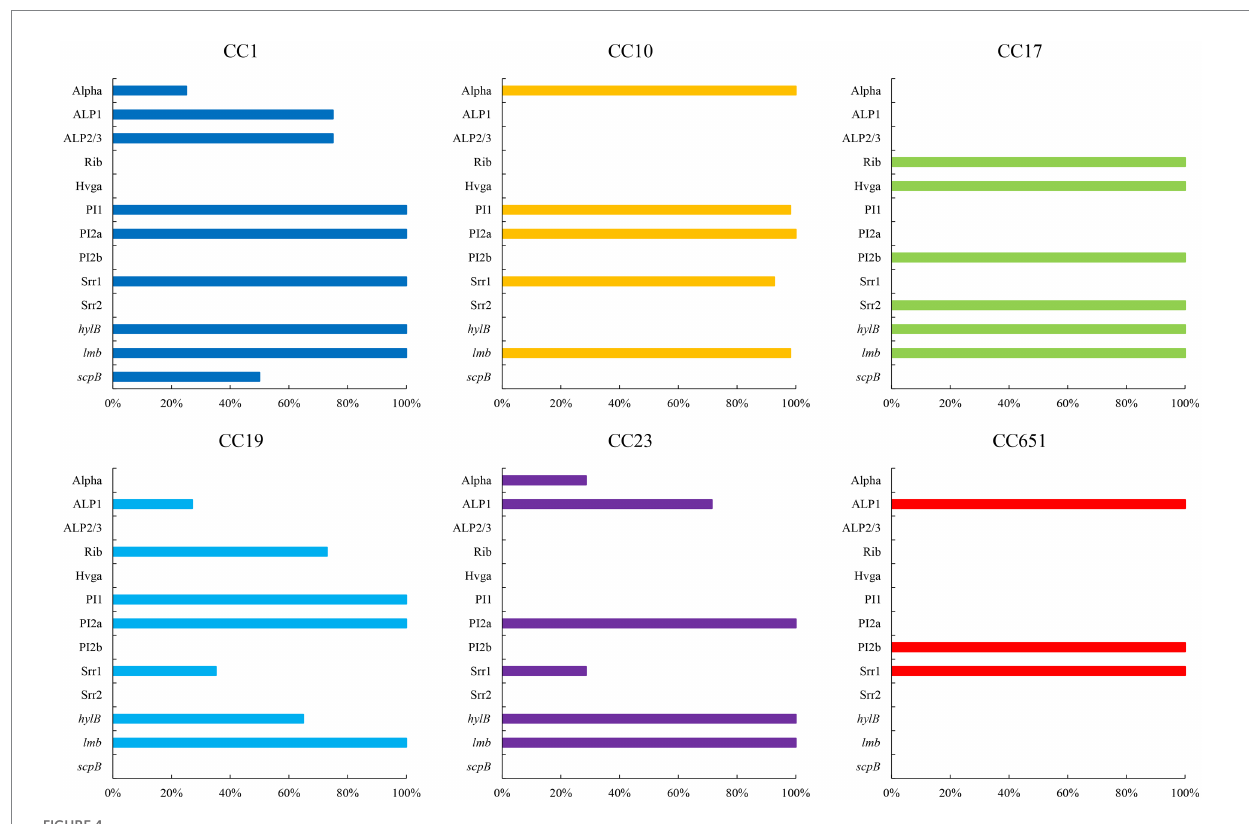
FIGURE 4 Virulence factors of strains with different CCs (%). Only virulence factors with significant difference among CCs are included ( p <